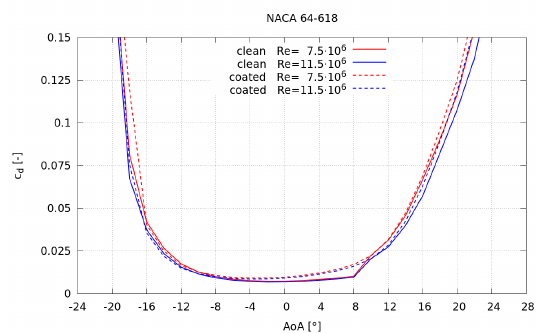
Figure 9. Numerical lift and drag coefficients c l , c d of clean and coated airfoils at Re = 7.5 × 10 6 and Re = 11.5 × 10 6 (“clean” refers to resolved boundary layer with transition model, whereas “coated” refers to a changed leading edge shape with resolved boundary layer and fully-turbulent flow model).